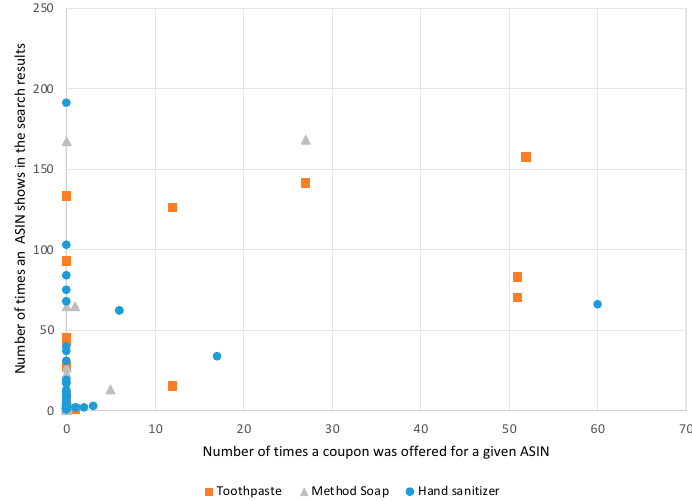
Figure 2. Number of coupons offered by ASIN. Table 3. Distribution of ASINs by coupon offering. Soap: Method body wash.